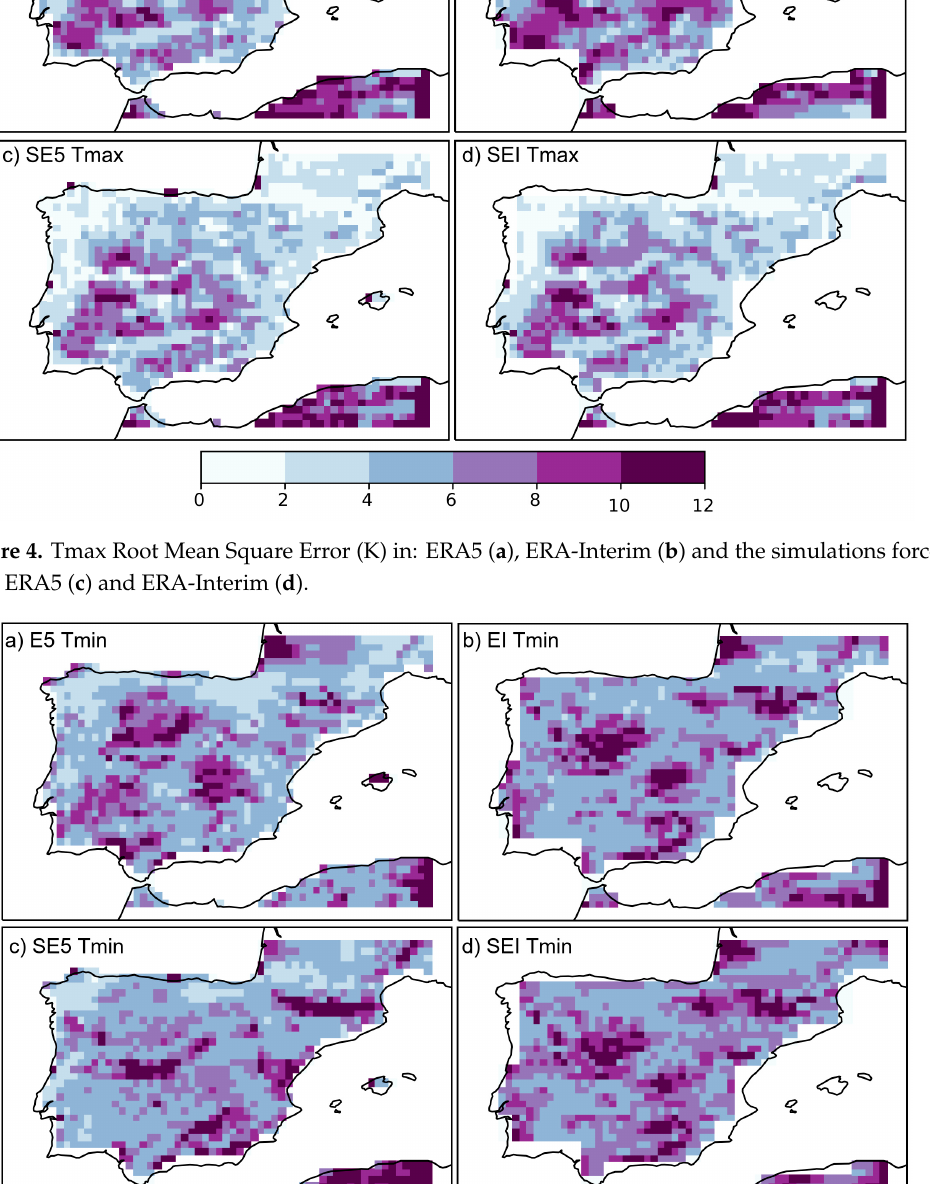
Figure 6. Tmax Mean Error (K) in ERA5 as function of the difference between CGLS ‐ FCover and ERA5 Total Vegetation Cover (TVC). The colors represent the clusters in Figure 2. The diamond marker represents the median value of each cluster. 3.2. Sensitivity Experiments 3.2.1. Vegetation Cover The original and revised (derived from ESA ‐ CCI) CVL and CVH in the Southern Portugal domain (see Figure S1) is presented in Table 3, and we determined the associated TVC using Equation (1). In all points, the dominant high vegetation type is ‘Interrupted Forest’ while the